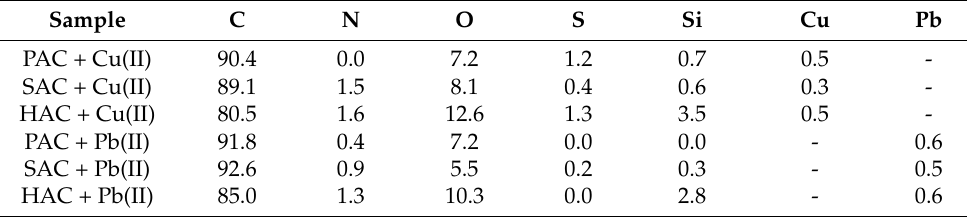
Table 9 contains the comparison of Pb(II) and Cu(II) adsorbed amounts on the dif- ferent carbonaceous adsorbents described in the literature and in the present